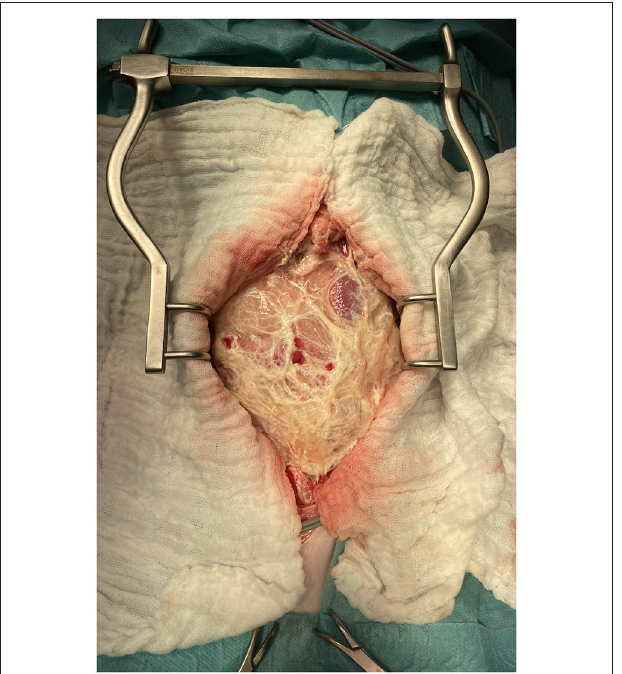
FIGURE 6 | Intraoperative picture of the laparotomy of C2 after abdominal wall incision. Note the thick fibrous membrane encapsulating the abdominal